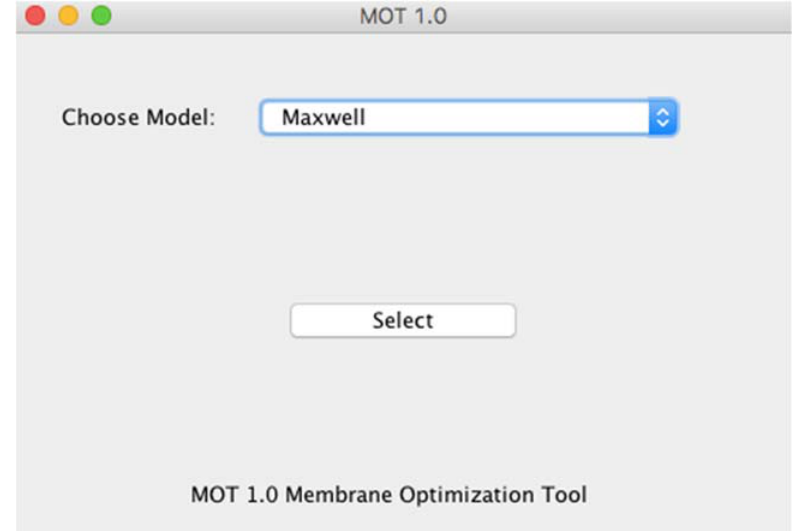
Figure 2. The main window for model selection.